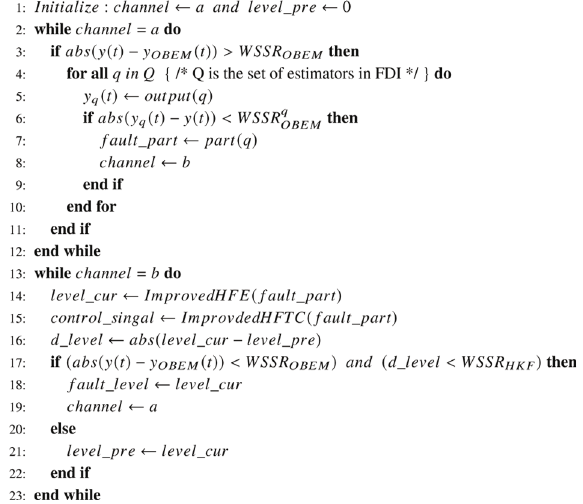
Figure 10: Channel switching algorithm.